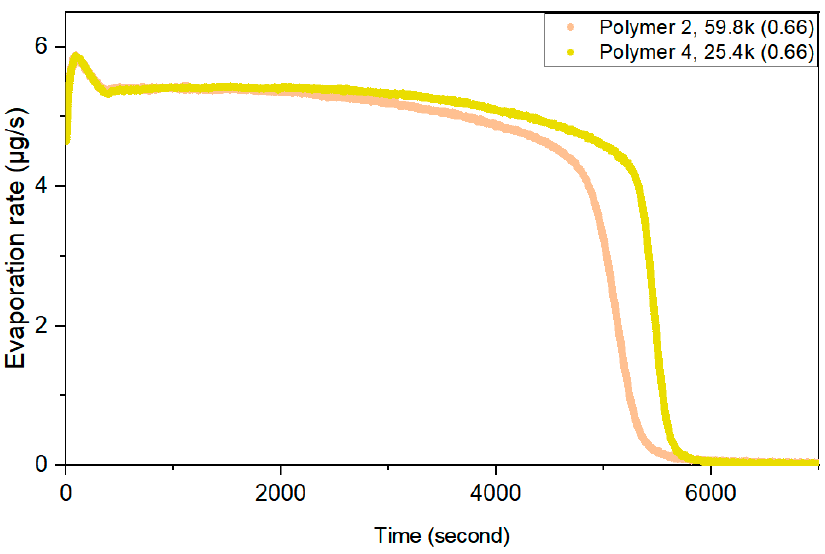
Figure 10. Evaporation rate of Polymer 2 (1.83 mmol/L) and Polymer 4 (1.87 mmol/L).